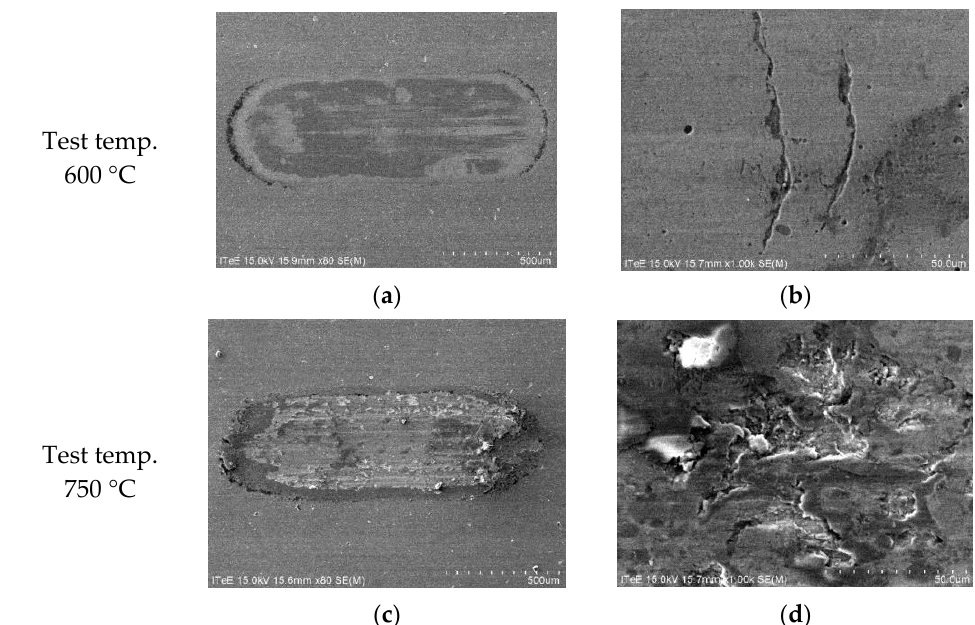
Figure 10. SEM micrographs presenting an overview of the contact zone on the disc made of Group I (Ti-TiB 2 ) composite with AlCrN coating, sintering temp. 1250 °C: ( a ) 600 °C; ( b ) a magnified view, 600 °C; ( c ) 750 °C; ( d ) a magnified view, 750 °C.